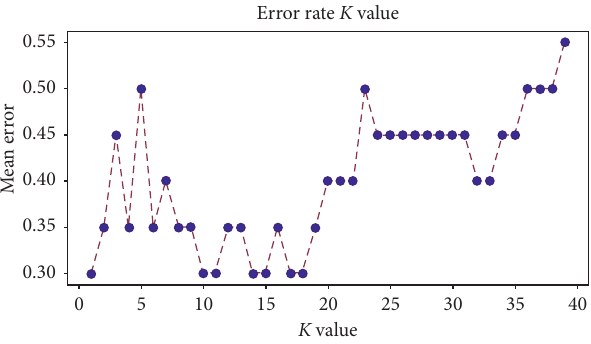
Figure 16: Error rate with respect to the k value.